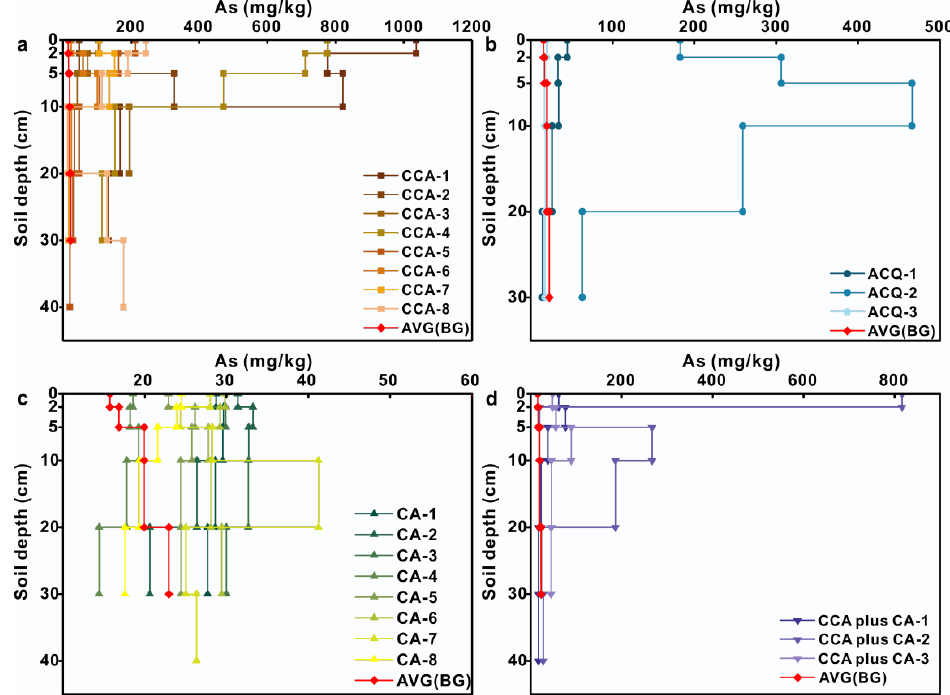
Figure 5. Vertical distribution of As concentration in soil samples under wooden walkway with four treatments: ( a ) CCA treatment; ( b ) ACQ treatment; ( c ) CA treatment; ( d ) CCA plus CA treatment.